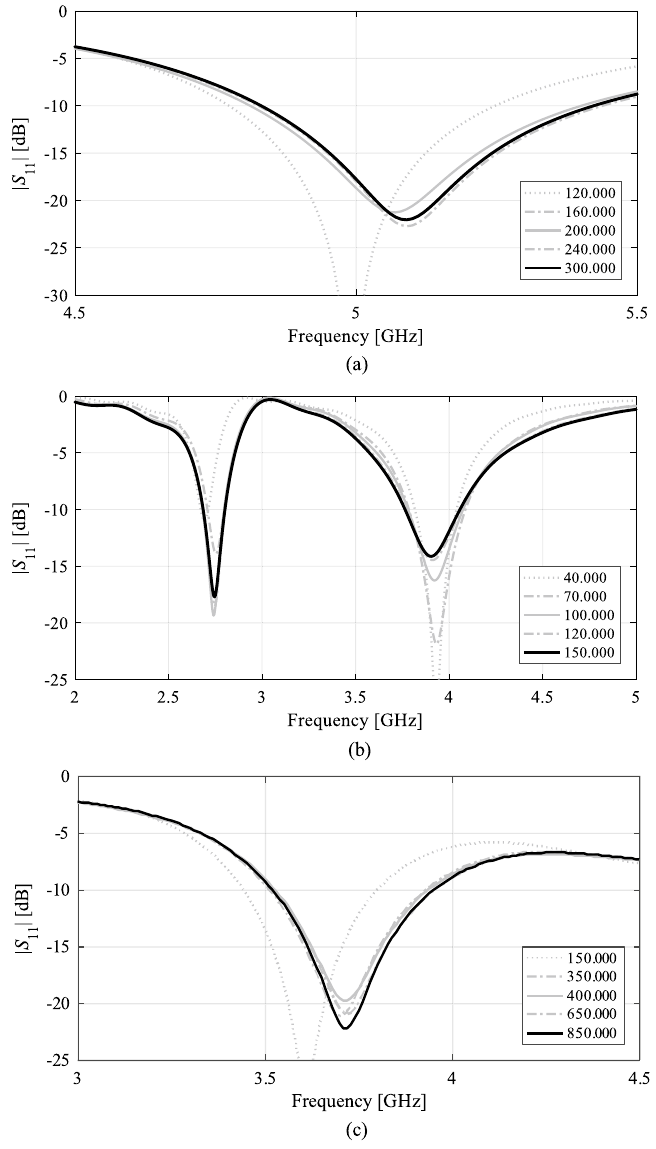
Figure 11. Grid convergence plots for: ( a ) Antenna I, ( b ) Antenna II, and ( c ) Antenna III for different numbers of mesh cells corresponding to various model fidelities from the lowest employed fidelity up to the highest one.